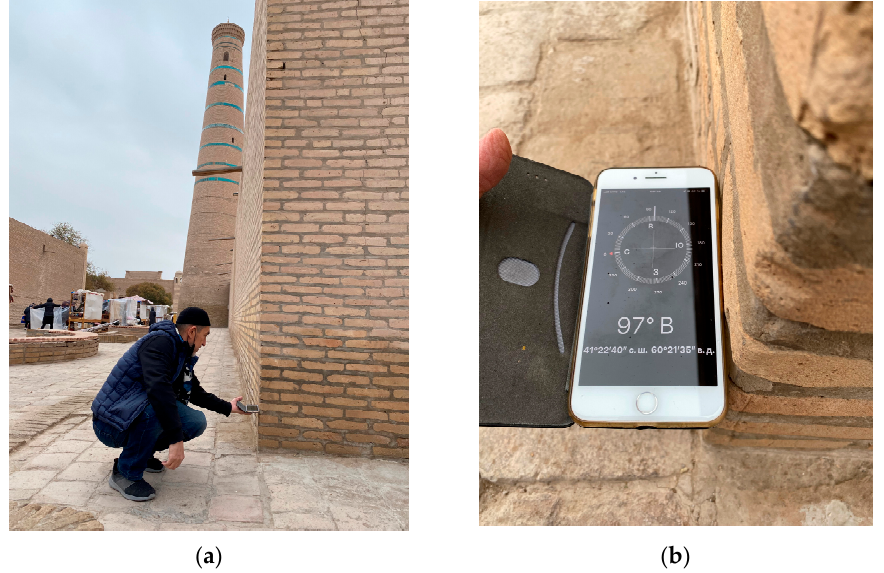
Figure 3. Estimation of the north wall’s orientation by an iPhone: ( a ) team member holds iPhone parallel to the wall; ( b ) angle measured by digital compass.